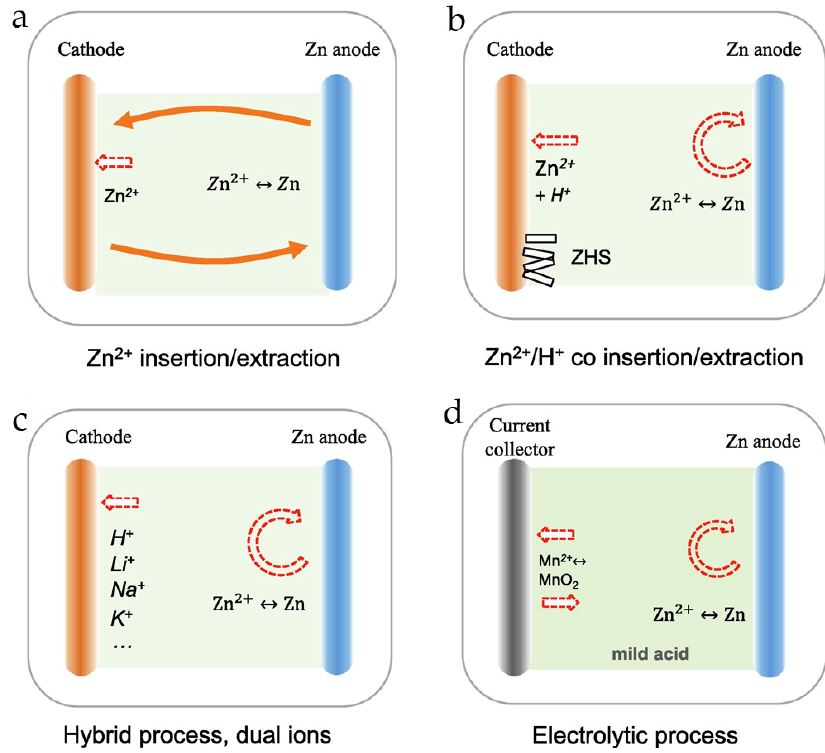
Figure 12. A general classification of working mechanisms of MnO 2 -based AZIBs: ( a ) Zn 2+ insertion/extraction, ( b ) Zn 2+ /H + (co)insertion/extraction, ( c ) hybrid process, and ( d ) electrolytic deposition/dissolution of MnO 2 [101].